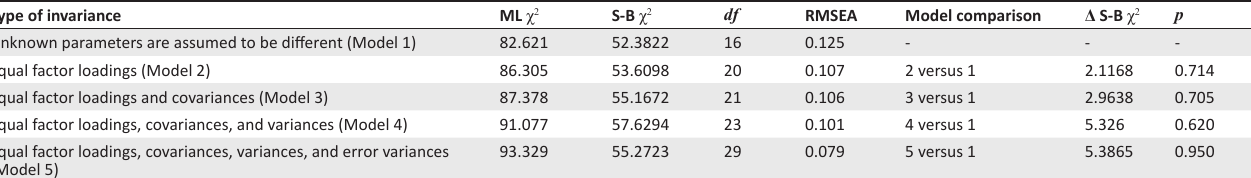
TABLE 6: Multi-group confirmatory factor analysis results (Gender). Type of invariance Unknown parameters are assumed to be different (Model 1)